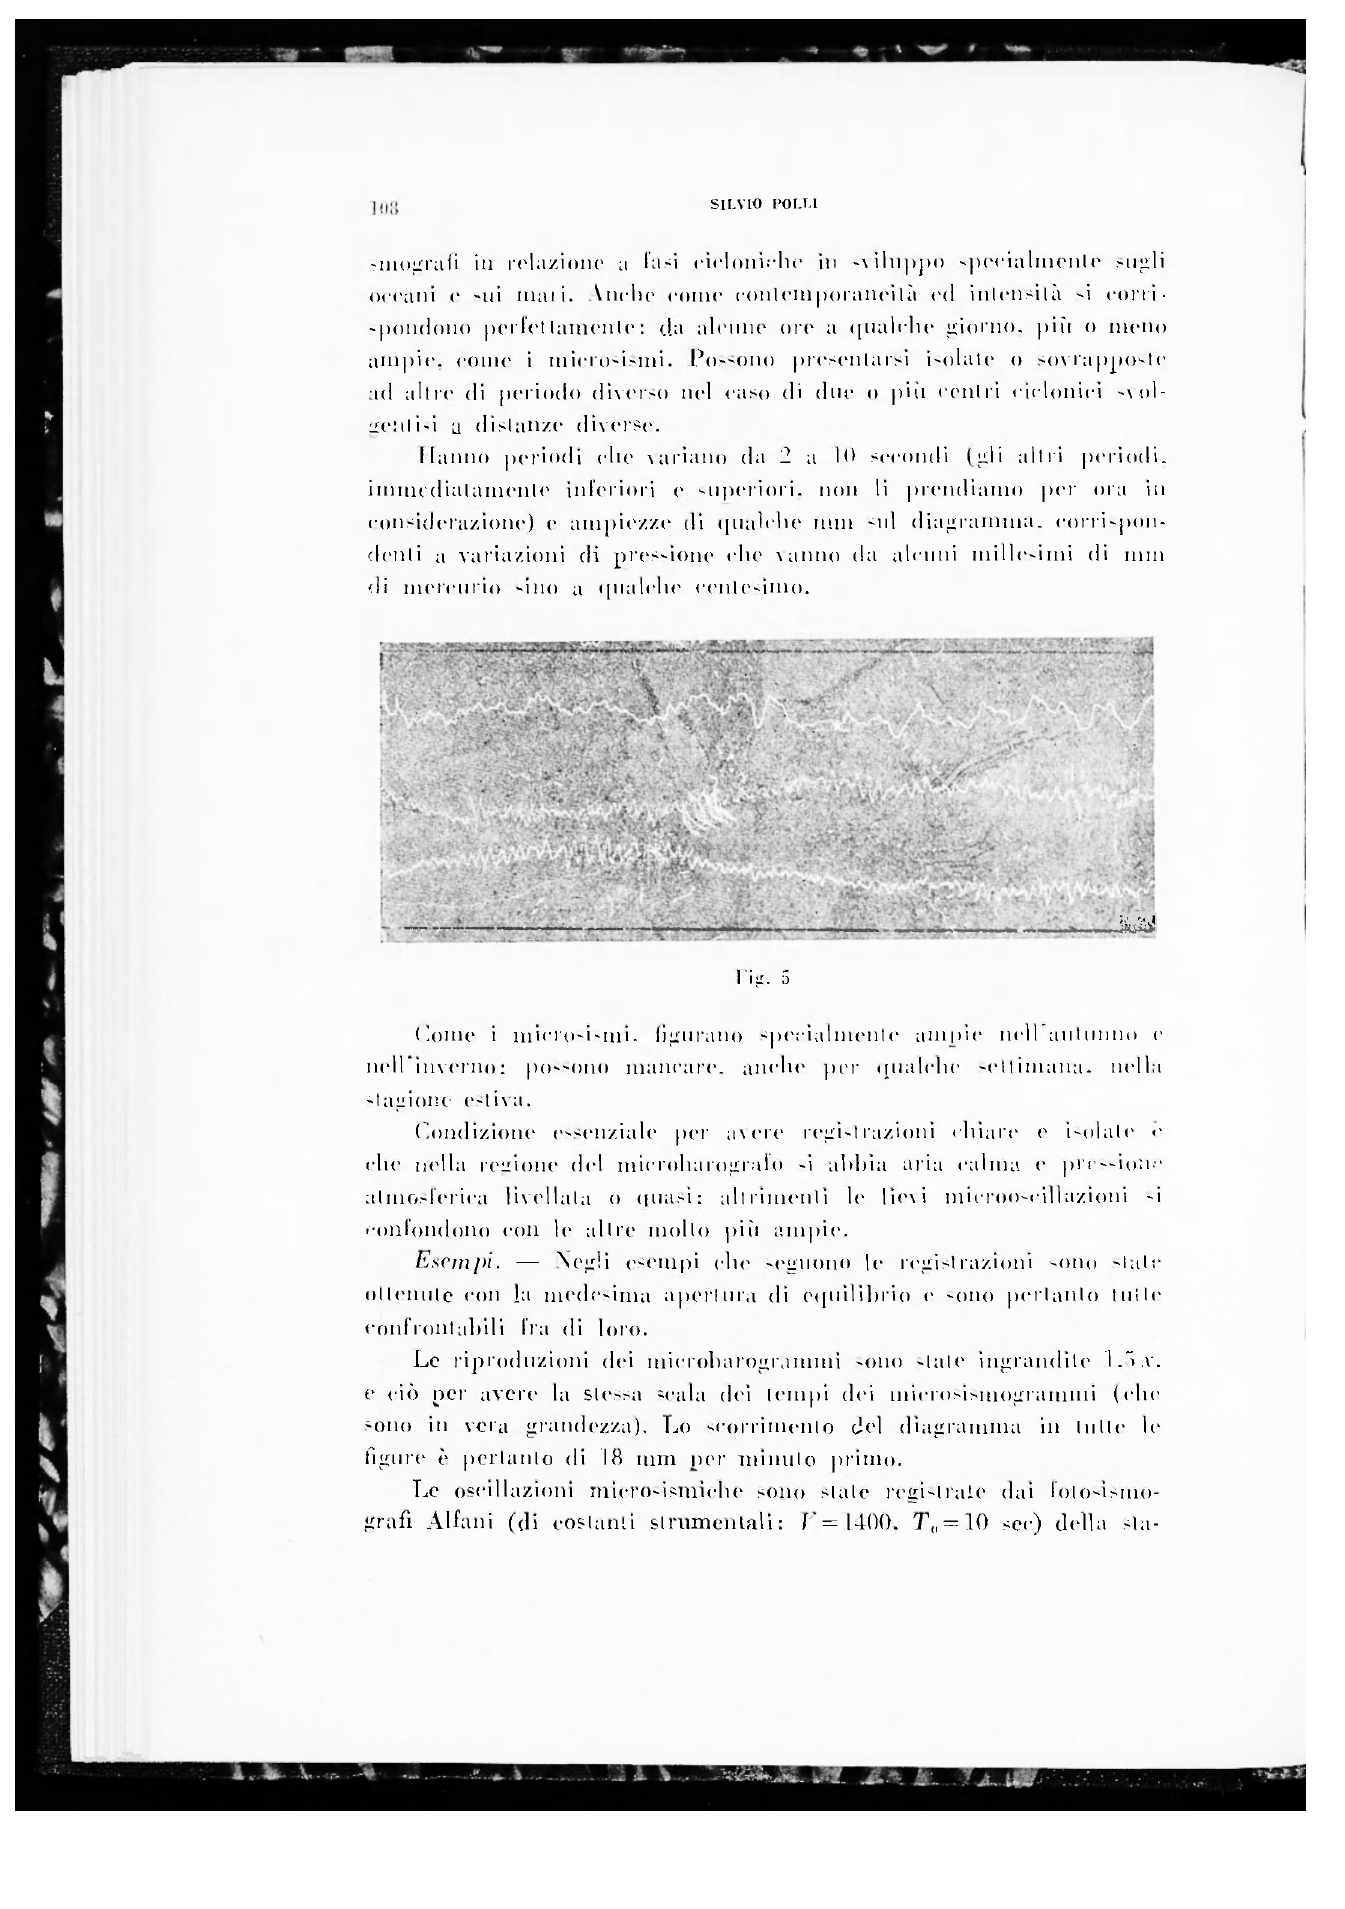
figure è p e r t a n to di 18 mm per m i n u to p r i m o. Le oscillazioni microsismiche sono state registrate dai